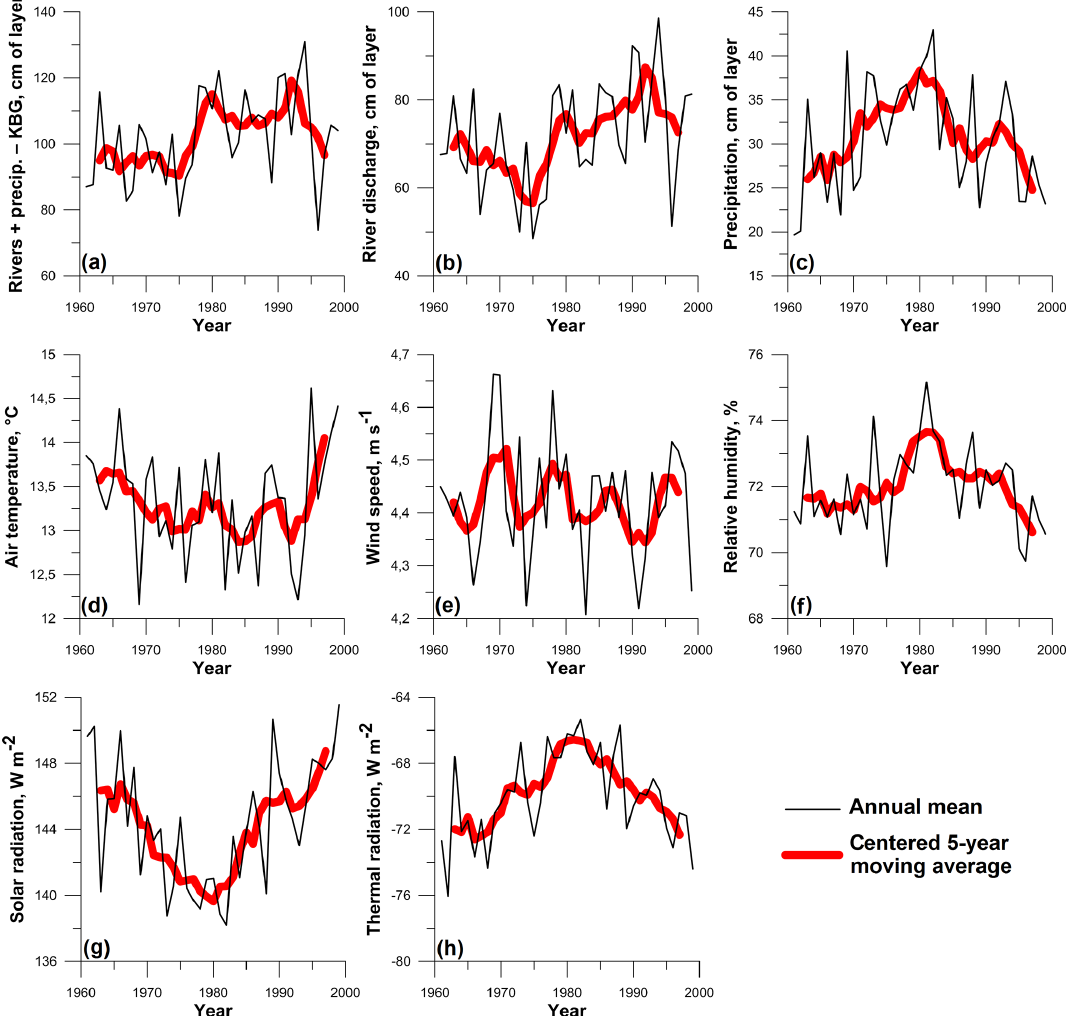
Figure 2. Long-term variability of the forcing components: (a) sum of riverine water input and precipitation with the deduction of the outward flux into the Kara-Bogaz-Gol Bay; (b) riverine water input alone; (c) precipitation; (d) air temperature ( ◦ C); (e) wind speed module (ms − 1 ); (f) relative humidity (%); (g) surface solar radiation (Wm − 2 ); (h) surface thermal radiation (Wm − 2 ). All atmospheric parameters and fluxes were averaged over the sea area; water fluxes (a, b, c) are given in terms of the corresponding sea level